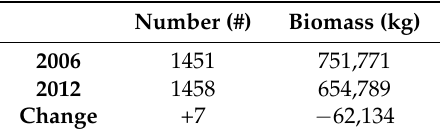
Table 6. Descriptive statistics on the above-ground biomass